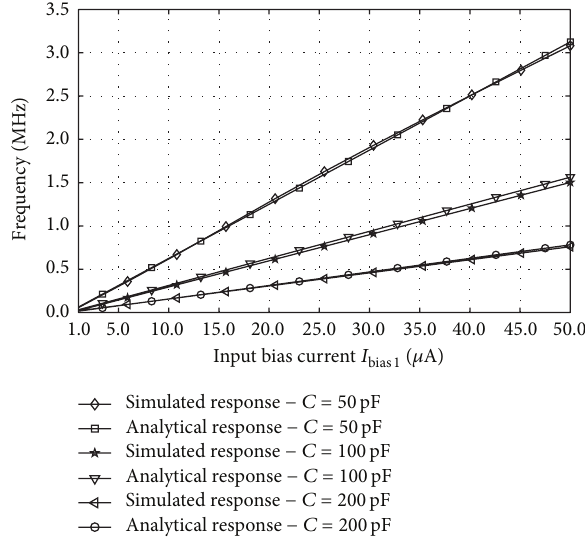
Figure 17: Frequency control of pulse generator.